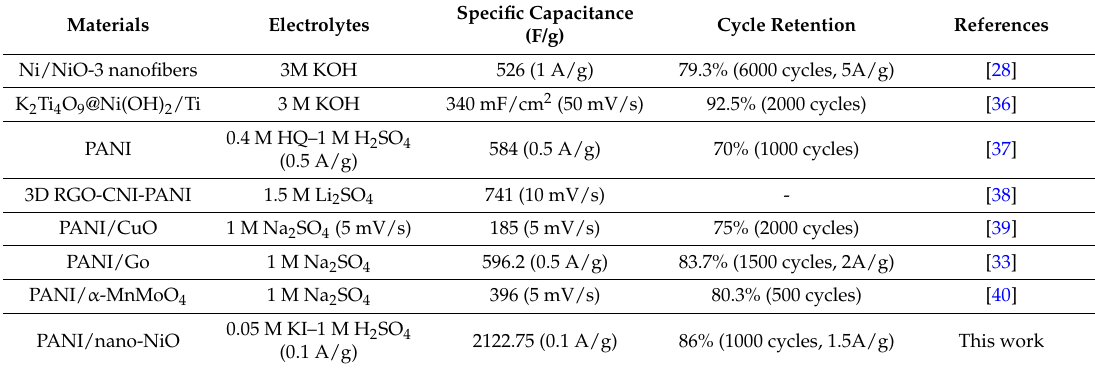
Table 2. Comparison of the specific capacitance and cycle retention.